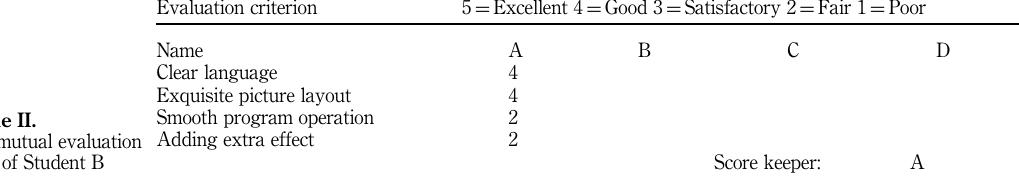
Table II. The mutual evaluation form of Student